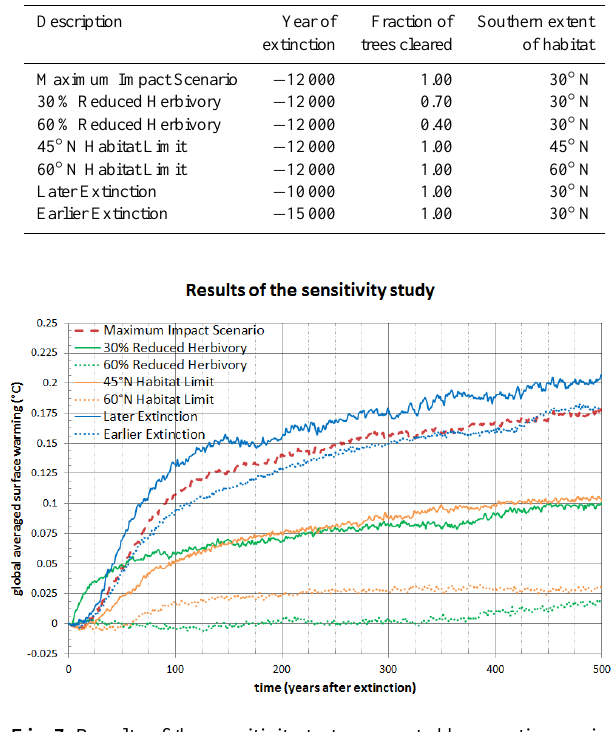
Fig. 7. Results of the sensitivity tests, presented here as time series of the difference in temperature (EXT-CTL) for various extinction scenarios. The MIS curve (same as dotted line in Fig. 1c) is shown in red for the sake of comparison.